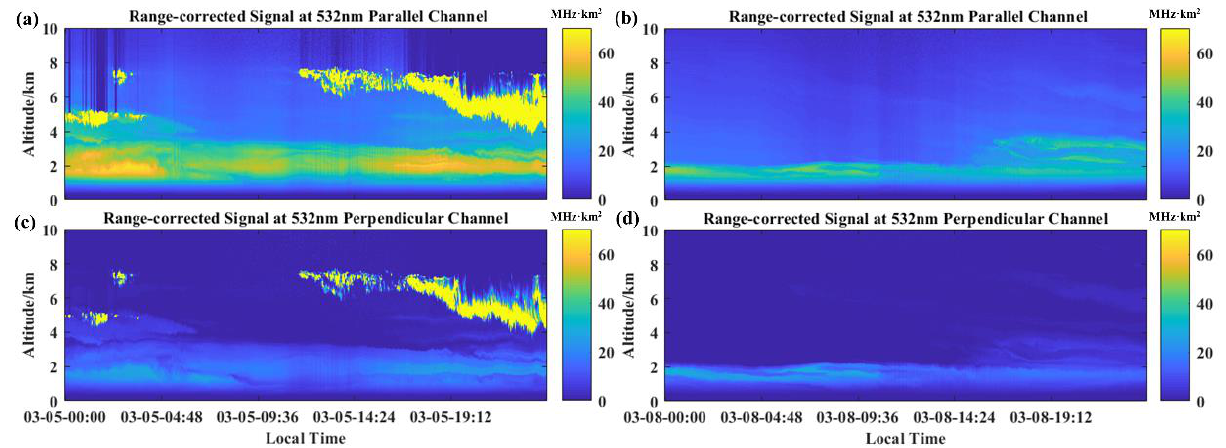
Figure 13. Range-corrected signal profiles in different weather: ( a ) 532 nm parallel Polarization channel on 5 March 2022; ( b ) 532 nm vertical Polarization channel on 5 March 2022; ( c ) 532 nm parallel Polarization channel on 8 March 2022; ( d ) 532 nm vertical Polarization channel on 8 March 2022.